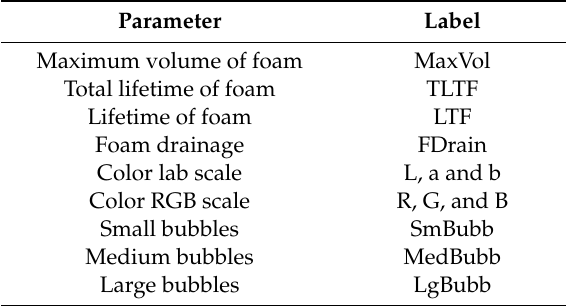
Table 3. Physical parameters analyzed using the